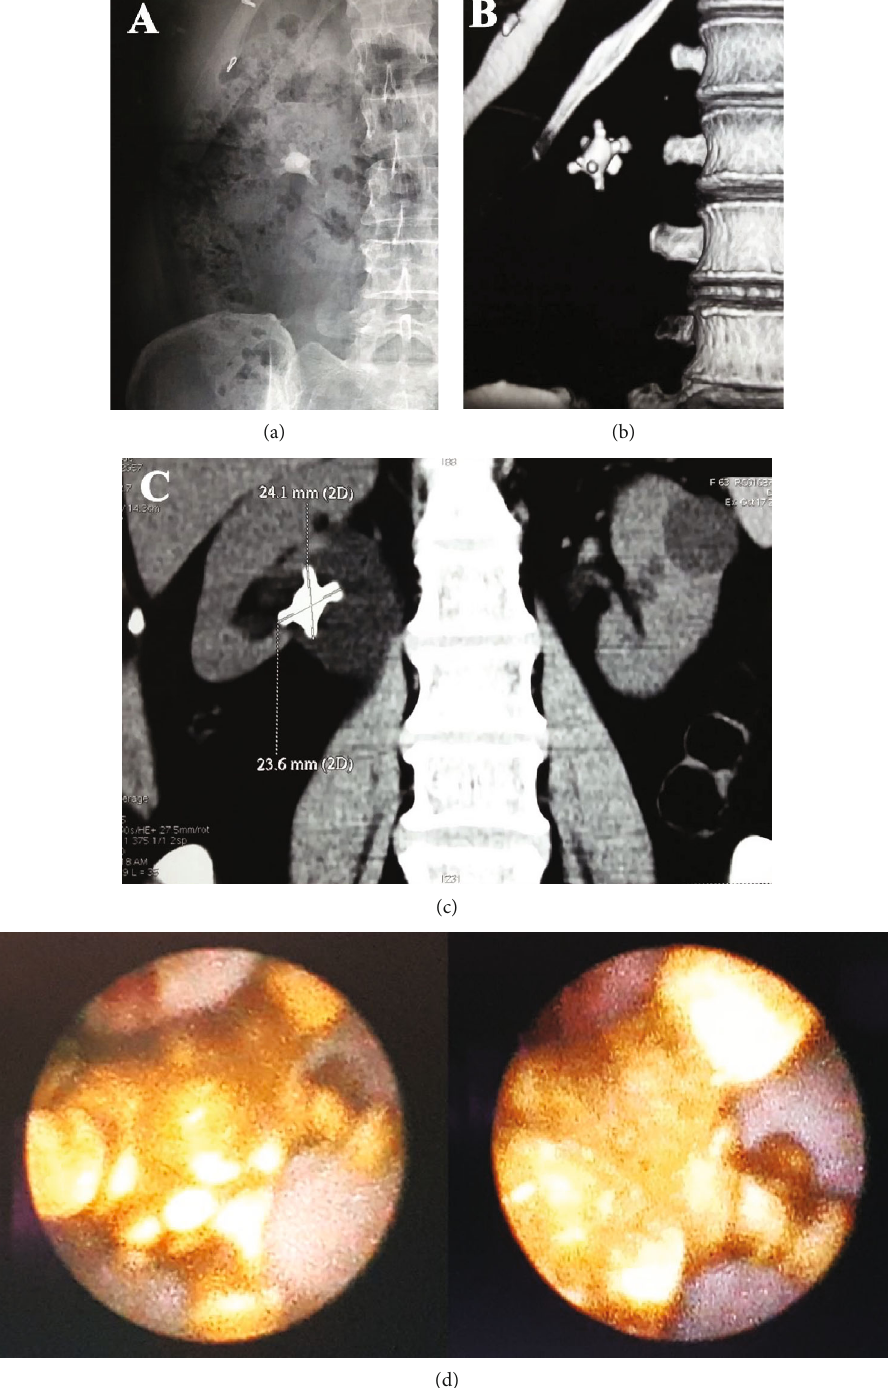
Figure 1: (a) X-ray: typical jackstone in the right kidney. (b) Reconstructed image of noncontrast computerized tomography (NCCT) con fi rming the presence of jackstone. (c) NCCT showing the right renal jackstone with mild hydronephrosis and no proximal hydroureter. (d) Endoscopic images showing a